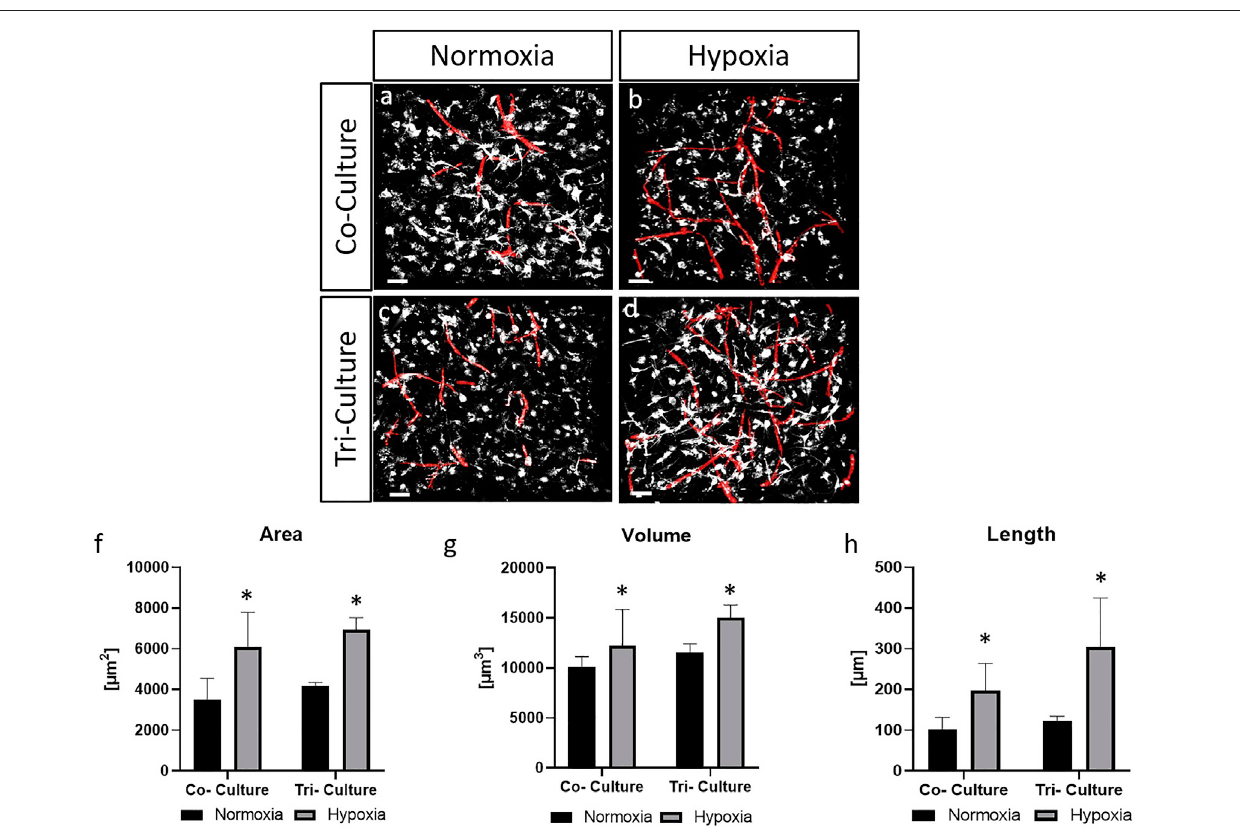
FIGURE 3 | CD31-stained HUVECs (red) and ASCs (grey) in co- and tri-cultures under normoxic and hypoxic culture conditions (A-D) , TPLSM images. Scale bar: 50 µm.Statisticalevaluationoftheparameters:areaofthevascularstructures (F) ,volume (G) andtotallengthofthestructures (H) .Thestatisticalsigni fi canceisprovided with * and shows the signi fi cance of the individual values for p < 0.05 and corresponding to the same cultures but different culture conditions.